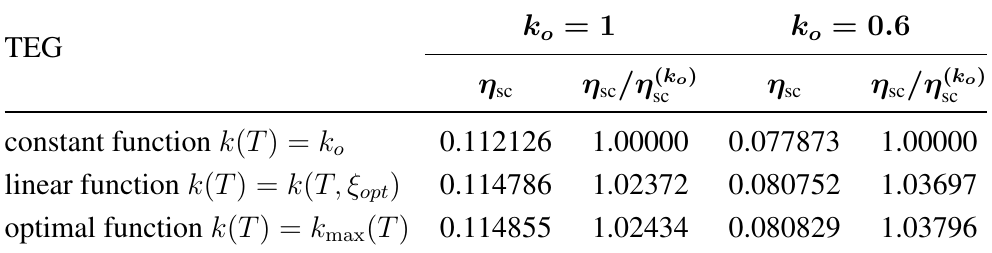
= 300 K and T = 600 K s a